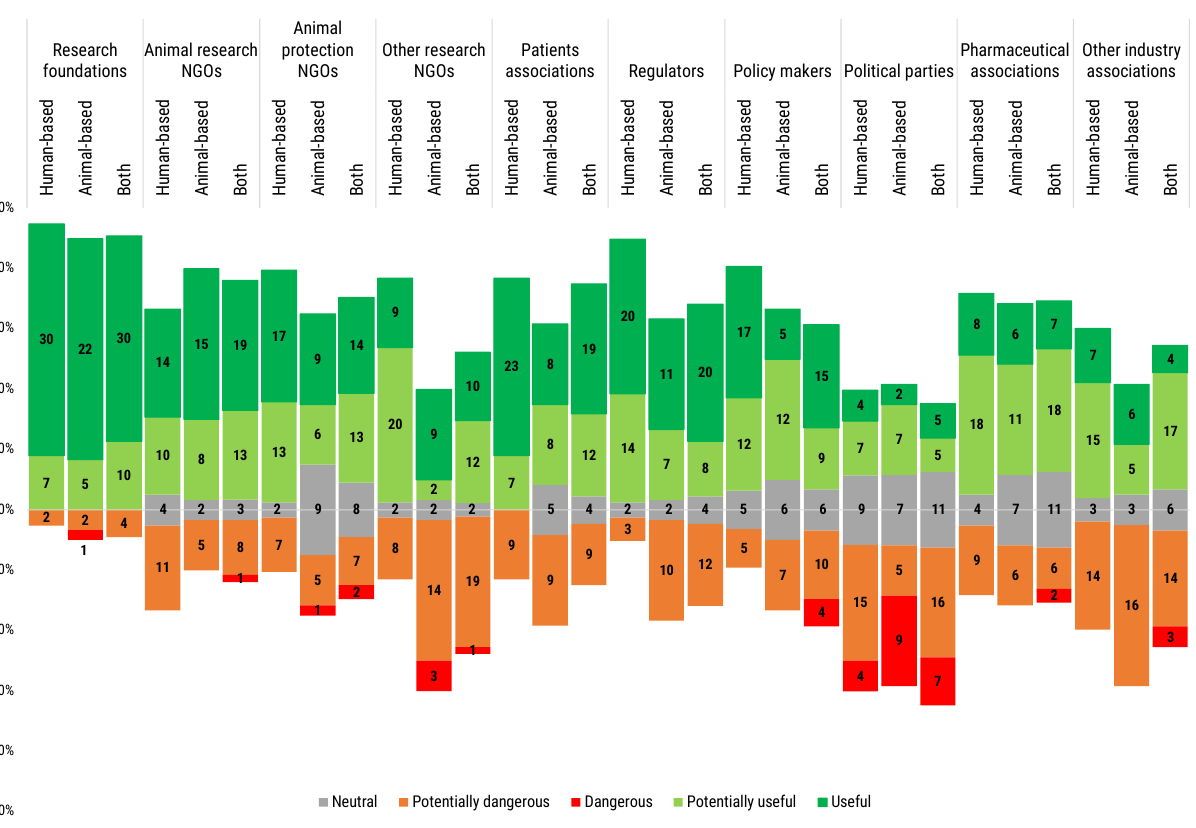
Figure 11. Participants answered the following question “What is your opinion on the participation of the following organisations in the scientific and political debates regarding the orientation of research?”. The stacked chart, calibrated around the neutral answers, shows the number of respondents based on their opinion, from “Dangerous” (in red) to “Useful” (in dark green), and segmented by researchers’ use of animal- or human-based or both models. Histogram dimensions are represented as 100%, where 100% is the total number of participants of each subgroup: human-based (39), animal-based (30) and both (44) model users.